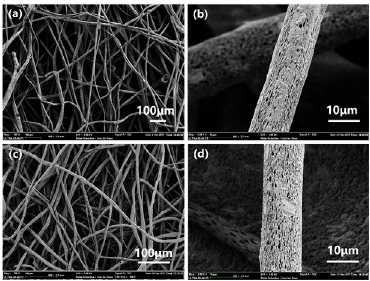
Figure 14. SEM of the first spinning ( a , b ) and the second spinning ( c , d ) of CTS-MMT composite fiber membrane.